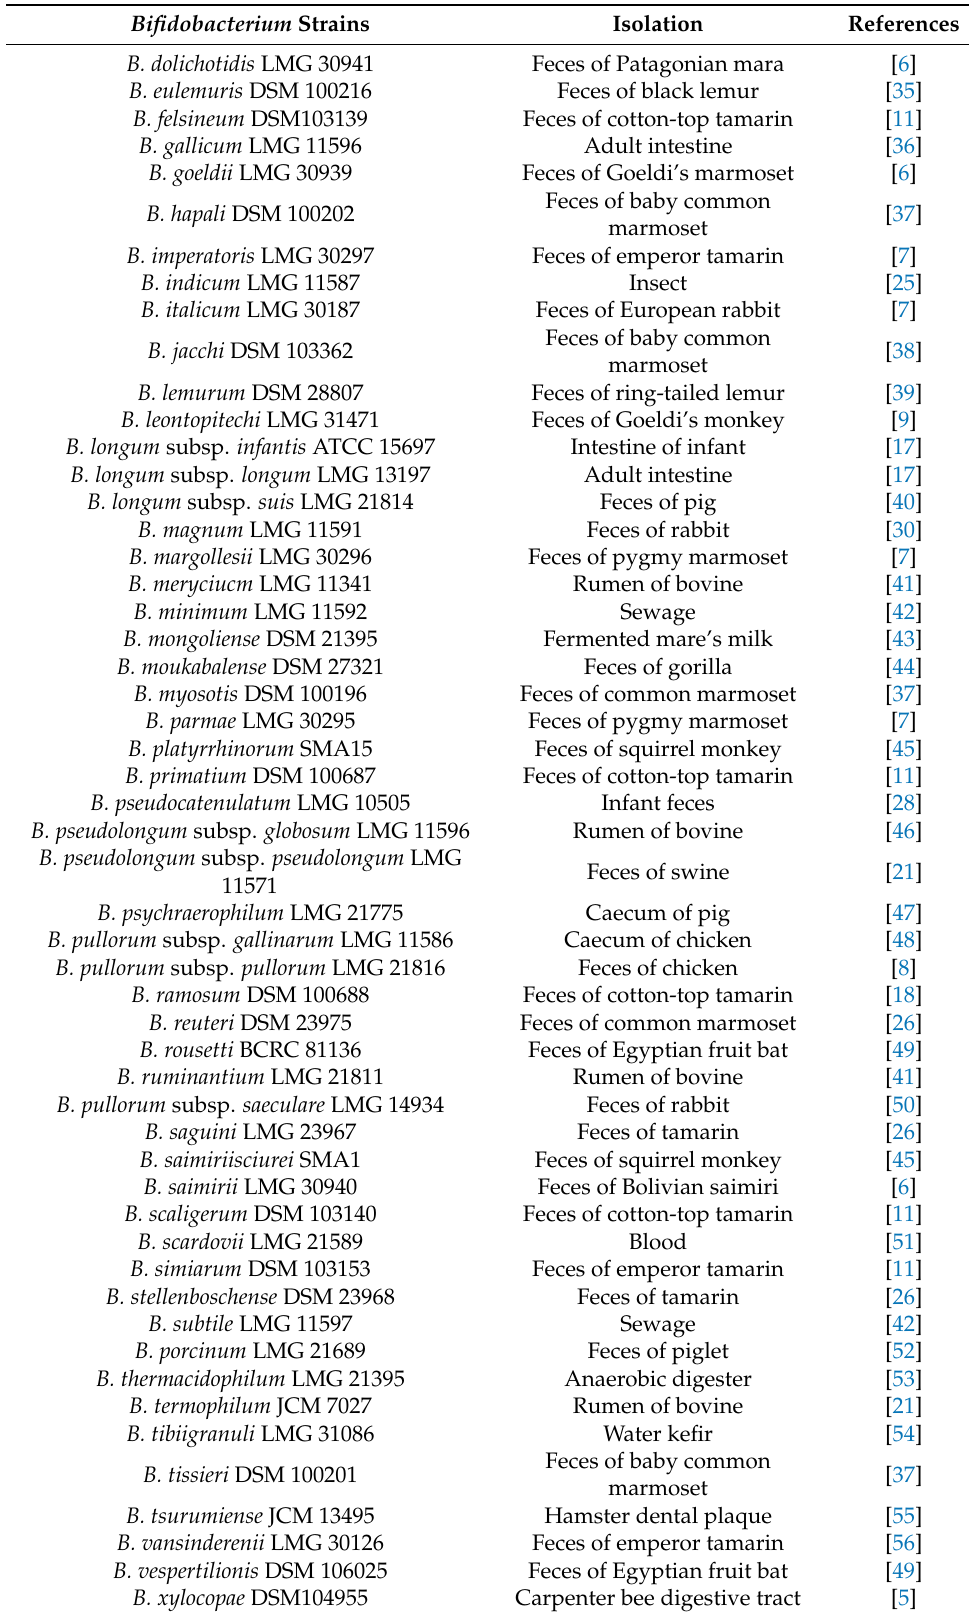
Table 1. Cont. Bifidobacterium